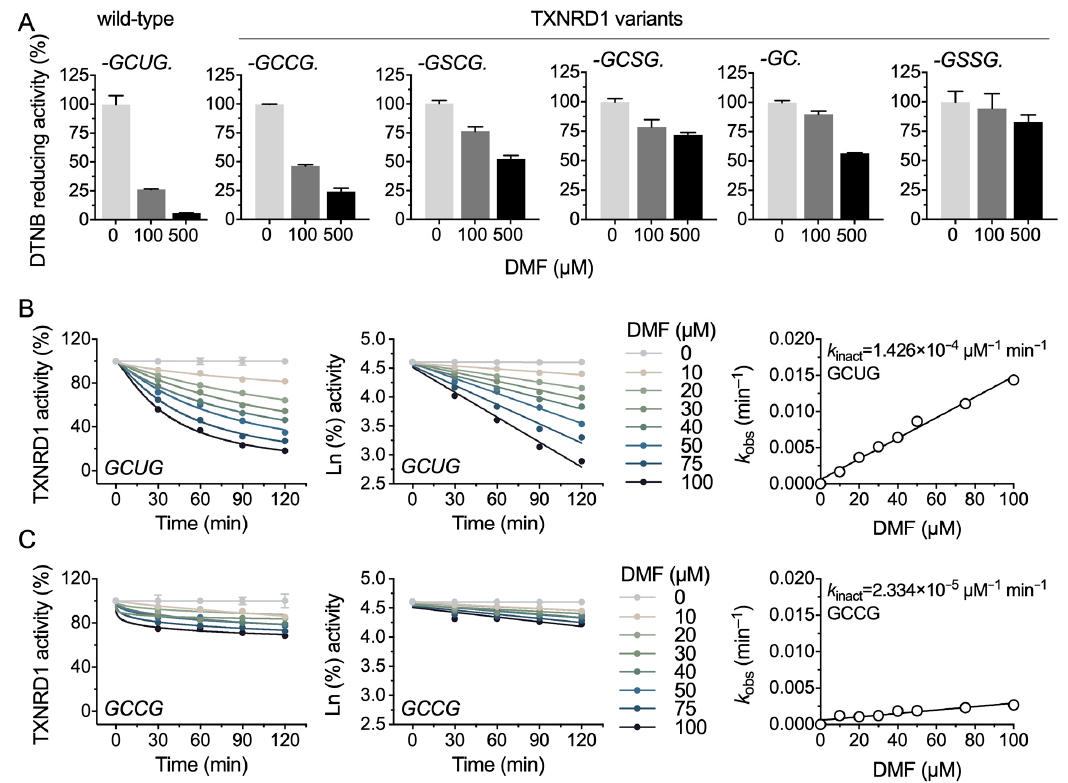
Figure 3. The C-terminal redox motif of TXNRD1 is more prone to be targeted by DMF than N- terminal domains. ( A ) Inhibition of TXNRD1 variants by DMF. Wild-type TXNRD1 (0.1 μ M) and its mutant variants (1 μ M) were pre-reduced by 100 μ M NADPH, and then treated with DMF for 2 h; the remained activity was determined by DTNB reducing activity. The final reaction mixture contained 10 nM wild-type TXNRD1 or 100 nM TXNRD1 mutant variants. ( B , C ) Time-dependent inhibition of DMF on wild-type rat TXNRD1 and its GCCG mutant. 0.2 µ M wild-type TXNRD1 and 2 µ M its GCCG mutant were pre-reduced by NADPH and then treated with DMF for the indicated time. The residual enzyme activity was assayed by DTNB reducing assay. Data are presented as mean ± SEM with three independent experiments.